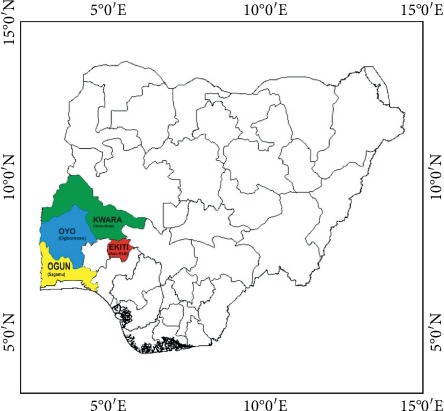
Map of Nigeria showing the study area.